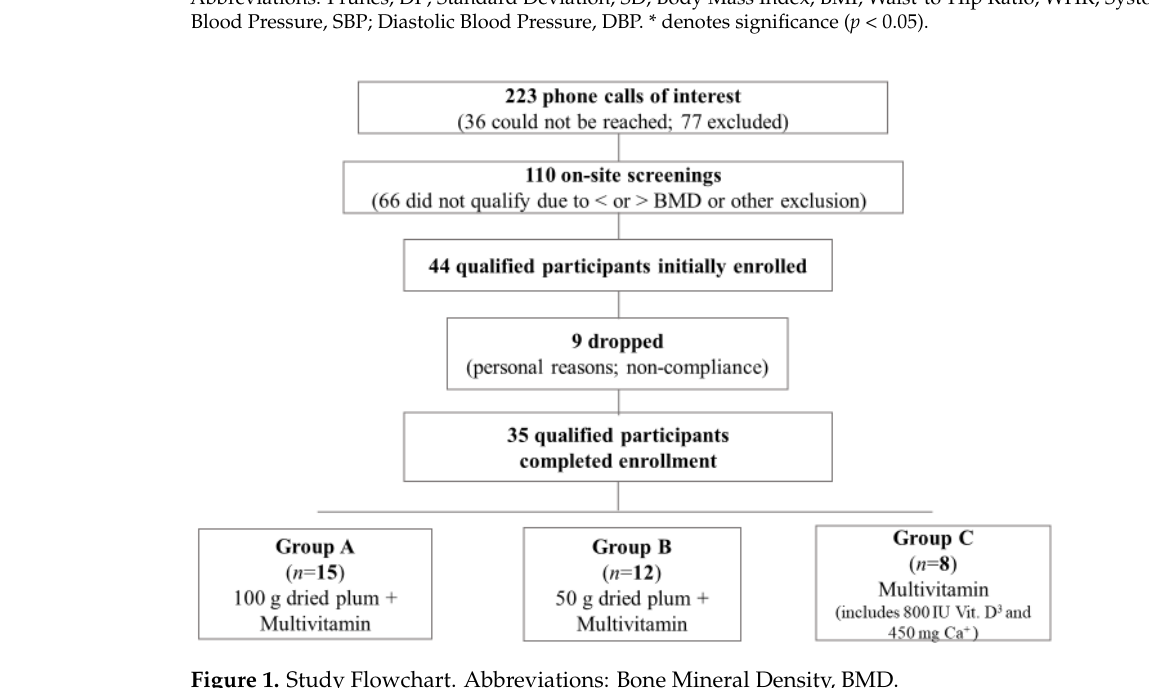
Table 3. Physical activity levels from baseline (Pre-) to 3 months